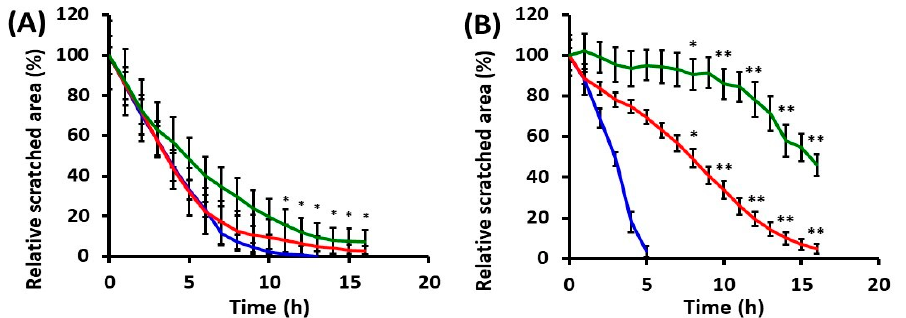
Figure 4. Effects of UVA exposure on the motility of keratinocytes, in terms of their ability to re-cover the scratched area. ( A ) HaCaT; ( B ) DOK. Blue plots—mock-irradiated cells; red plots—cells after 30 min irradiation; green plots—cells after 60 min irradiation. * p < 0.05, ** p < 0.01.